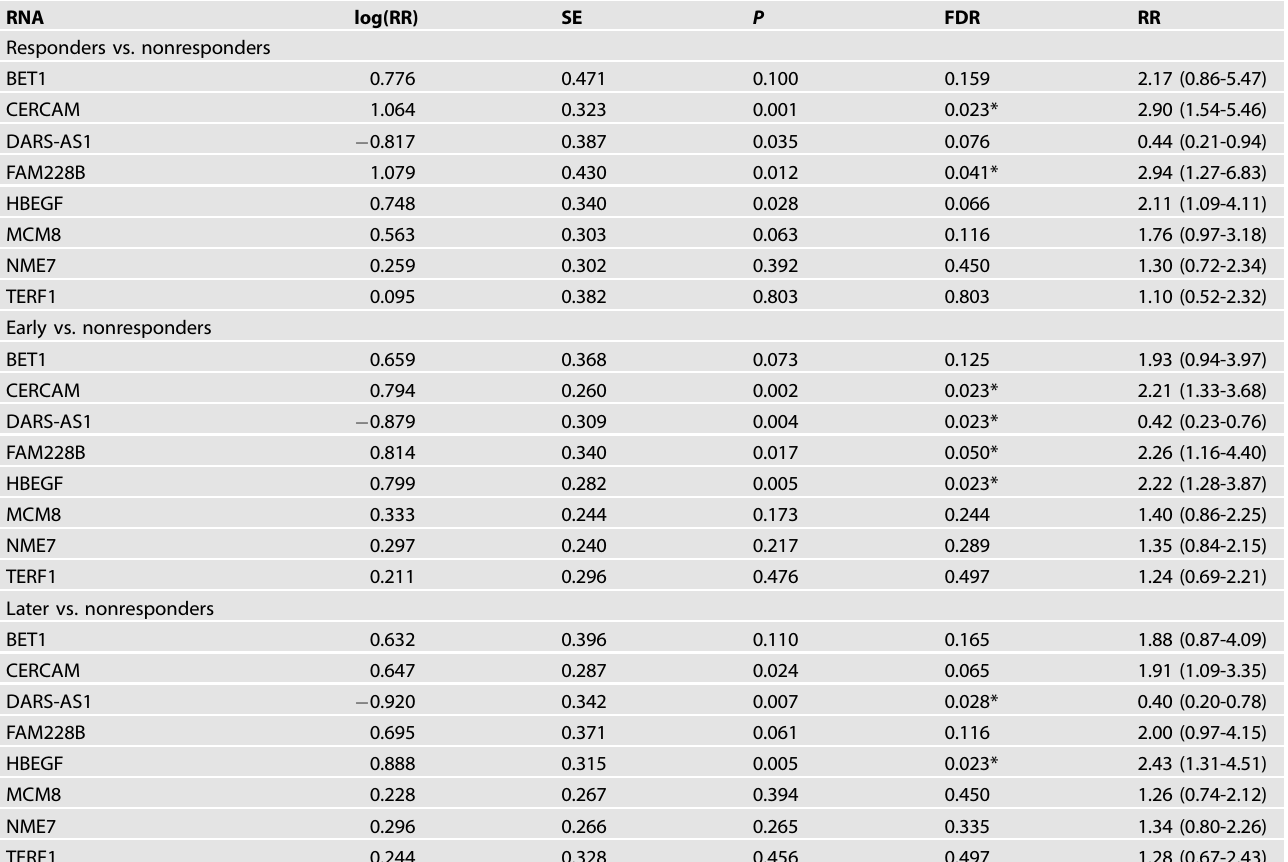
Table 2. Association between changes in RNA expression and risk response